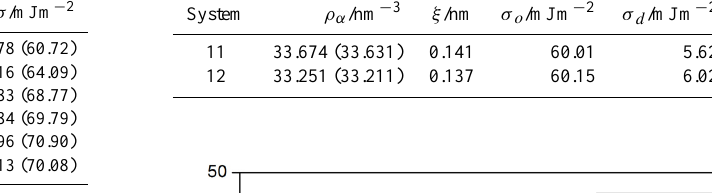
Table 3. Calculated liquid density, radius for equimolar dividing surface, work of formation, and surface tension for spherical inter- faces in systems 7–10. Shown in parentheses are the data calculated by fitting to the error function.